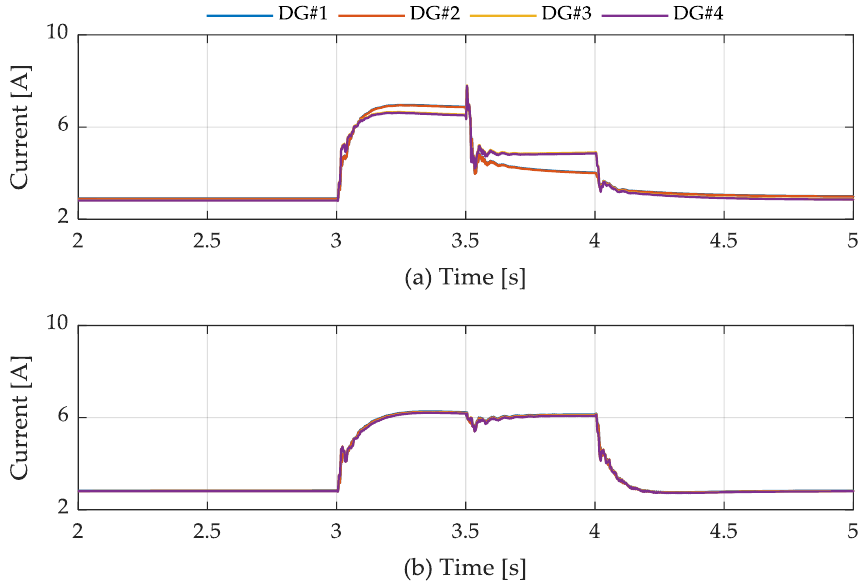
Figure 17. Output current of each DG: ( a ) centralized method; ( b ) proposed method.